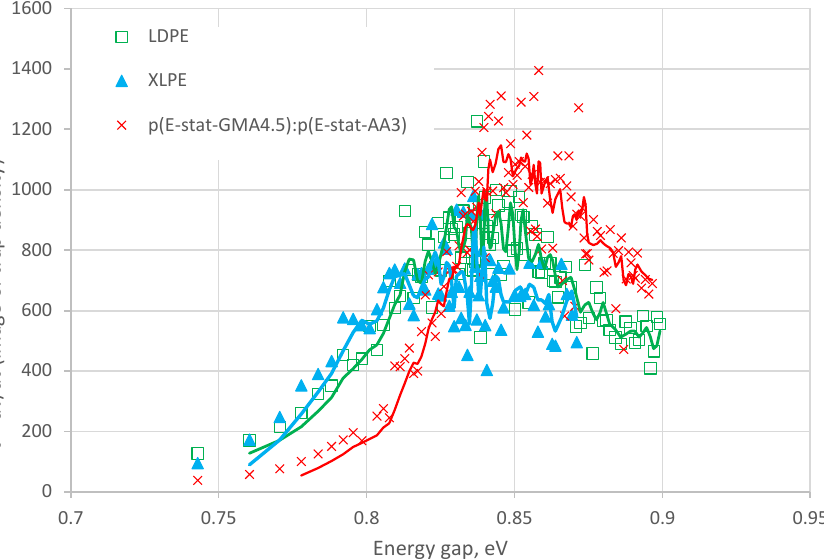
Figure 10. Image of trap density distribution derived from surface potential decay; solid lines represent a moving average fit of the data.